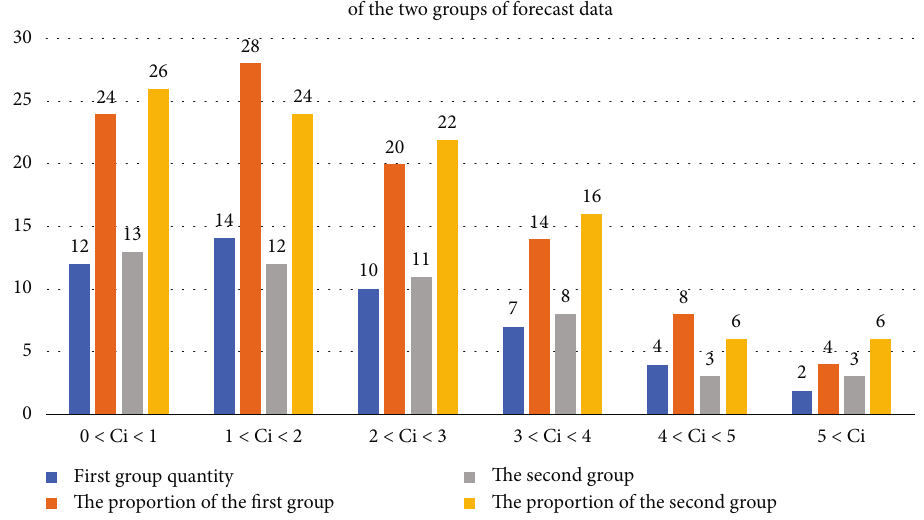
Figure 9: Distribution of the absolute error between the actual value and the predicted value of the two groups of forecast data.